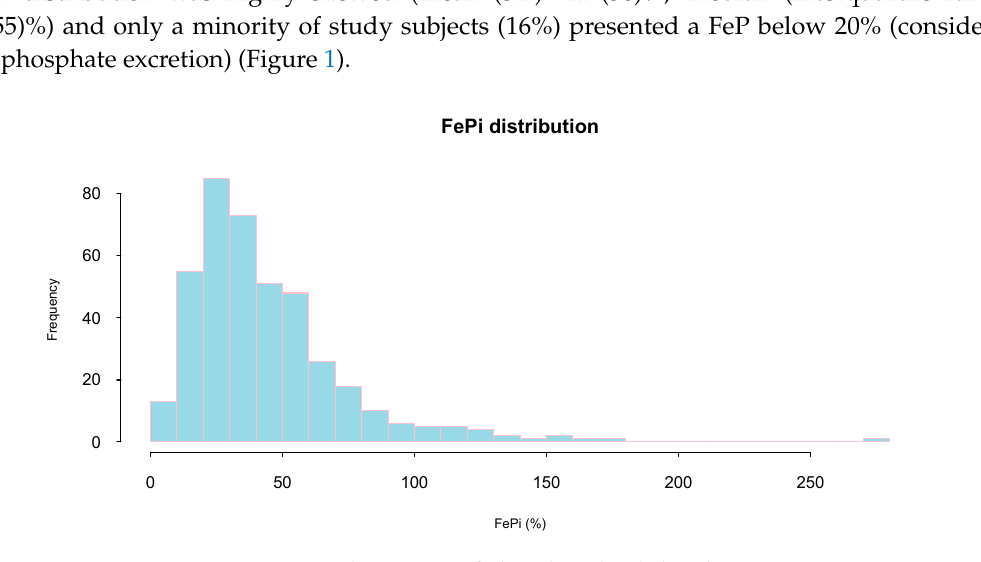
Figure 1. Fractional Excretion of Phosphate (FeP) distribution.